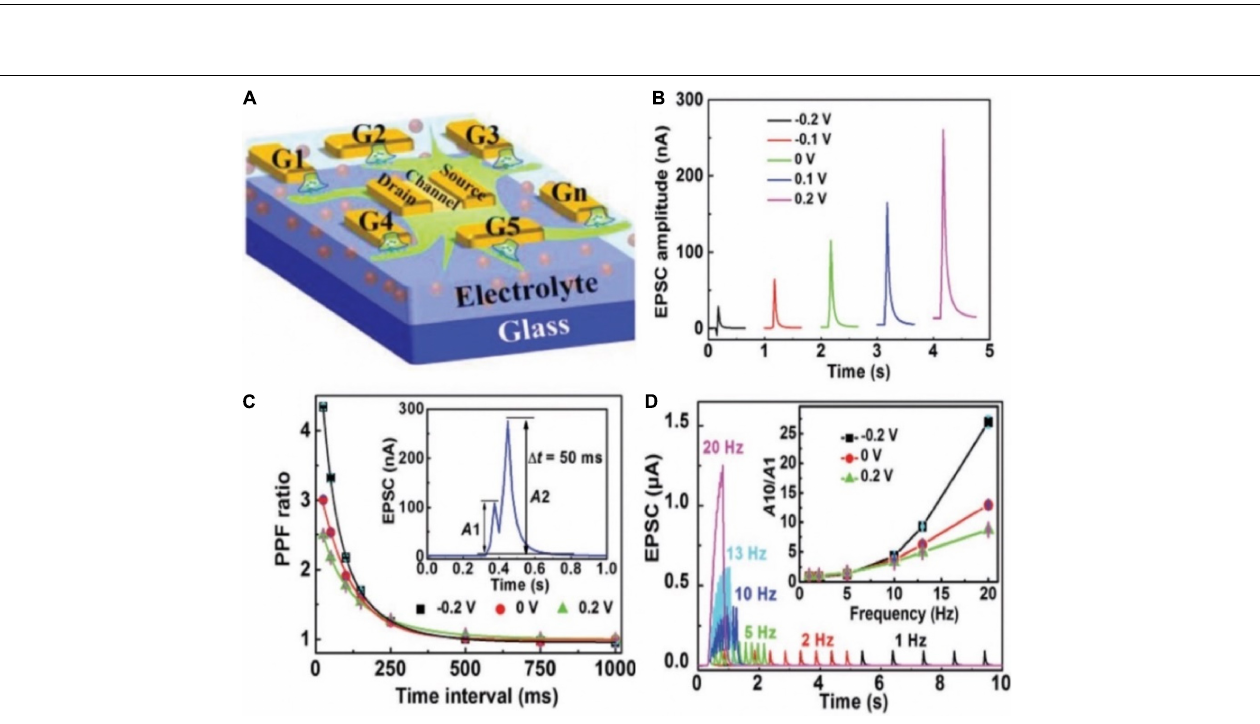
FIGURE 9 | (A) Schematic diagram of the multiterminal artificial synaptic device. (B) EPSCs triggered by G 1 with different G m . (C) PPF ratio plotted as the function of time interval between a pair of pulses under different G m . Inset: EPSCs triggered by a pair of pulses with time interval of 50 ms when there is no G m bias. (D) EPSCs triggered by spike trains containing 10 spikes with different frequencies when there is no G m bias. Inset: EPSC amplitude gain (A 10 /A 1 ) changes with presynaptic spike frequency under different G m (adapted from He et al., 2019).